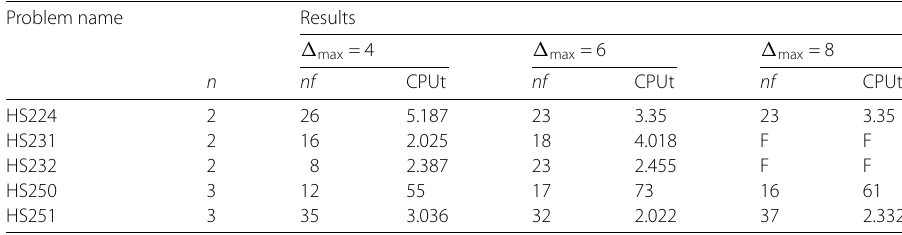
Table 2 Experiment results on linear inequality constrained optimization problems Problem